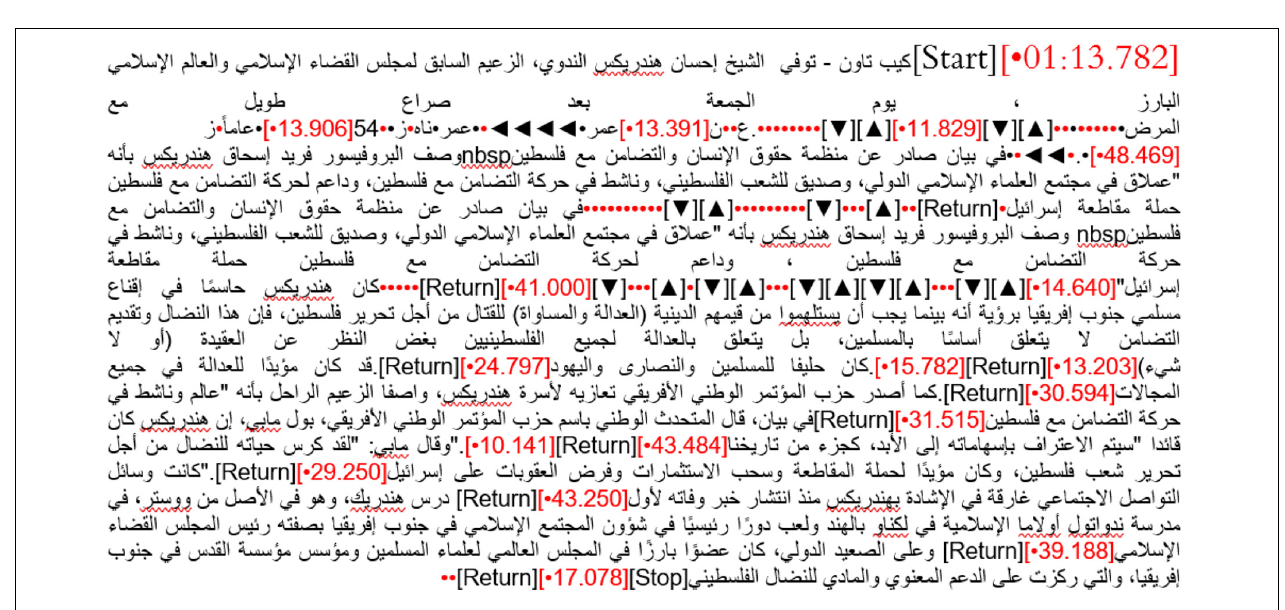
FIGURE 7 | Heat map showing the translation of some expressions in project 2.